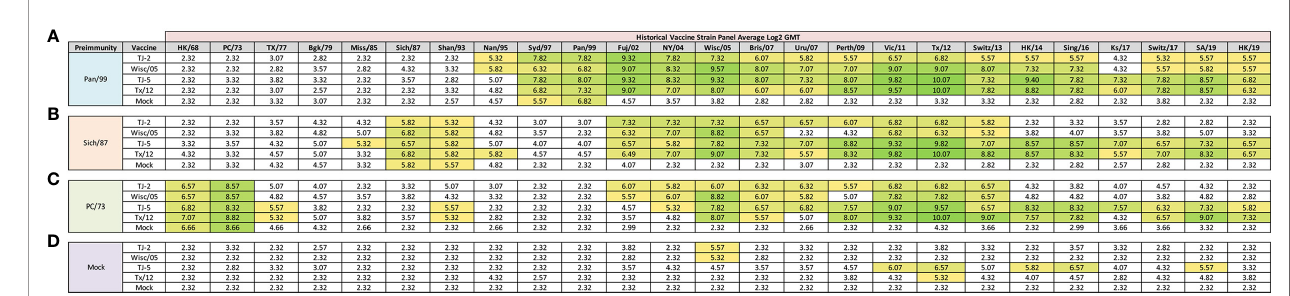
FIGURE 4 | Day 198 H3N2 Historical Vaccine Strain HAI Panel. Serum collected from animals 182 days post infection (14 days after second vaccination) was analyzed for HAI activity against a panel of historical H3N2 in fl uenza vaccine strains spanning 1968-2019. Table is divided into sections based on the virus each animal received to establish preimmunity: A/Panama/2007/1999 (A) , A/Sichuan/2/1987 (B) , A/Port Chalmers/1/1973 (C) , or PBS (Mock) (D) . Cells in table are color coded as a heat map based upon Log(2) HAI geometric mean titer (GMT) for each group of ferrets (N=4). The heat map colors cells yellow at Log(2) GMT of 5.32 which correspond to an HAI titer of 1:40 and cells become a darker shade of green as the average antibody titer of the group increases. Cells with no color correspond to groups that did not achieve a GMT